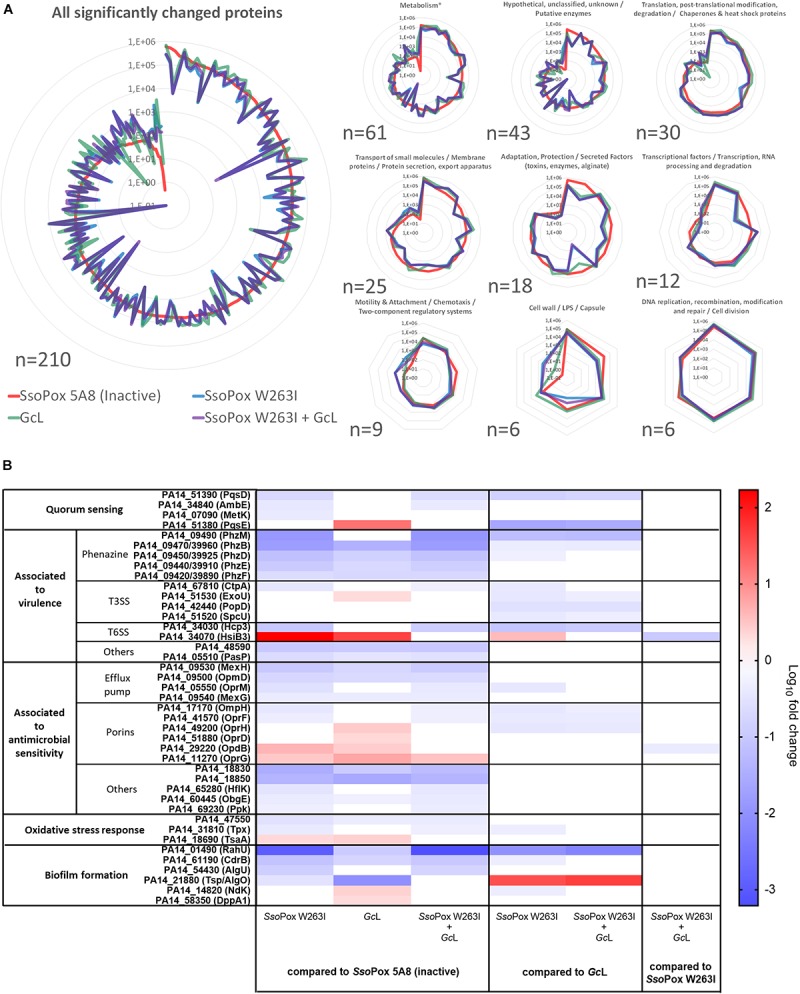
Fluctuations in P. aeruginosa PA14 proteomes reflect enzyme-mediated phenotypic changes. For each active enzyme or their mixture, 2 U.mL–1 activity on 3-oxo-C12 HSL was used. The inactive variant SsoPox 5A8 was used at the same protein quantity as SsoPox W263I. (A) Global modifications of PA14 proteome in response to lactonase treatment. The mean of normalized intensities for each condition are plotted. Only the 210 significantly changed proteins were used. The proteins are grouped according to PseudoCAP classification (http://www.pseudomonas.com). ∗Metabolism: Amino acid biosynthesis and metabolism/Biosynthesis of cofactors, prosthetic groups and carriers/Carbon compound catabolism/Central intermediary metabolism/Energy metabolism/Fatty acid and phospholipid metabolism/Nucleotide biosynthesis and metabolism. (B) Highlighted modifications of PA14 proteome in response to lactonase treatment. Heat map of the log10 relative fold change mean for the six comparisons.